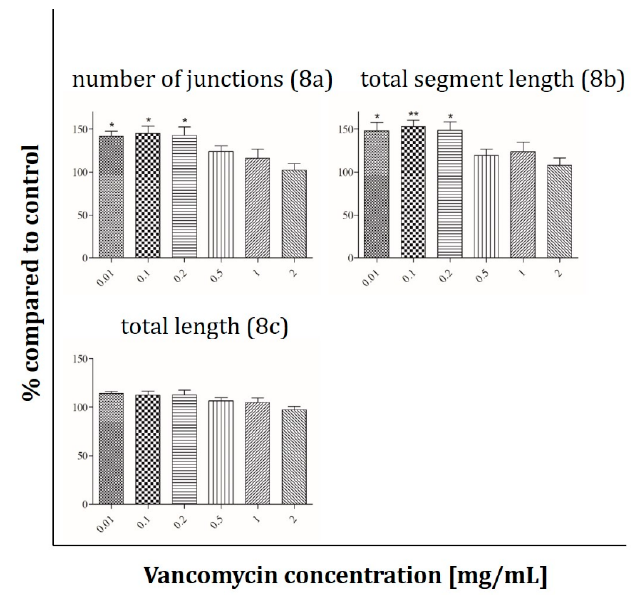
Figure 8. Tube formation assay of HUVEVs after exposure to vancomycin. Parameters used for evaluation of the results were: number of junctions ( a ), total segment length ( b ) and total length ( c ) (* p < 0.05; ** p < 0.01; *** p < 0.001 to control. The results are presented in percentage of the control without vancomycin (100%).